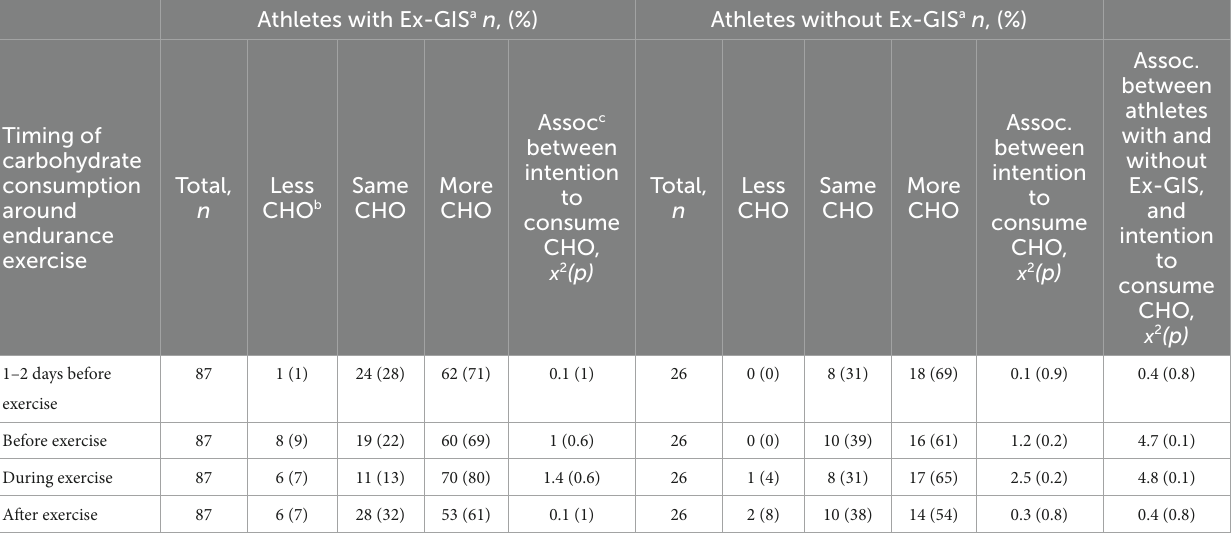
TABLE 5 Endurance athletes intentions to consume carbohydrate around exercise measured as the level of agreement using a three point Likert scale from eat less to eat more, for athletes with ( n = 87) or without ( n = 26) exercise-associated gastrointestinal symptoms.